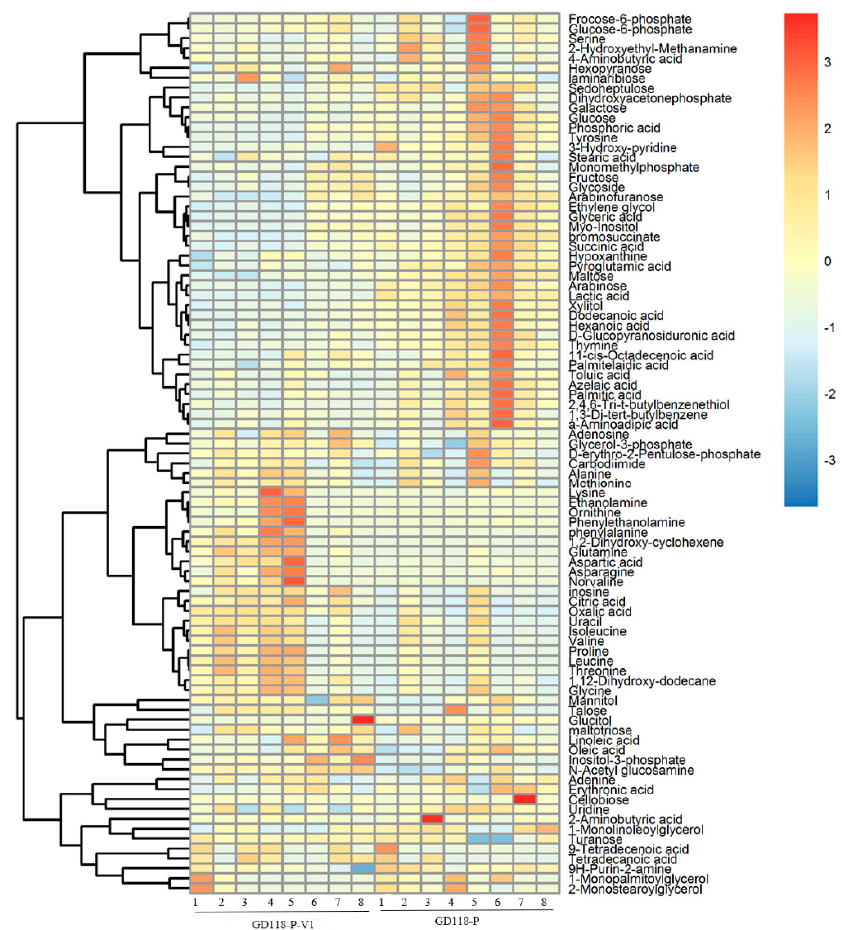
Figure 6. Clustering analysis of the metabolic data of isogenic fungal samples. Notes: Heat map showing the clustering of detected metabolites into three metabolite classes across 16 samples. Each row represents the level changes of a metabolite in all samples. Red colors indicate metabolite levels greater than the median value (yellow colors), and blue colors indicate metabolite levels lower than the median value (yellow colors).